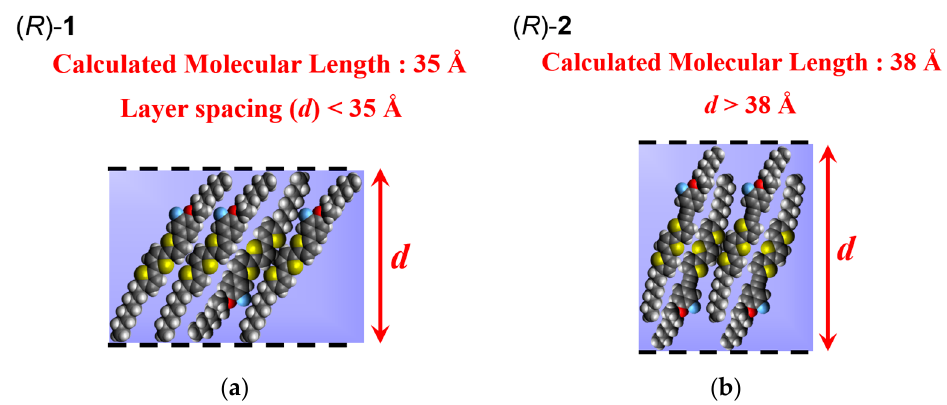
Figure 7. Schematic illustrations of the molecular packing models in the ( a ) SmC* phase of ( R )- 1 (monolayer structure), and ( b ) SmC d * phase of ( R )- 2 (interdigitated layer structure) assumed from the XRD profiles.